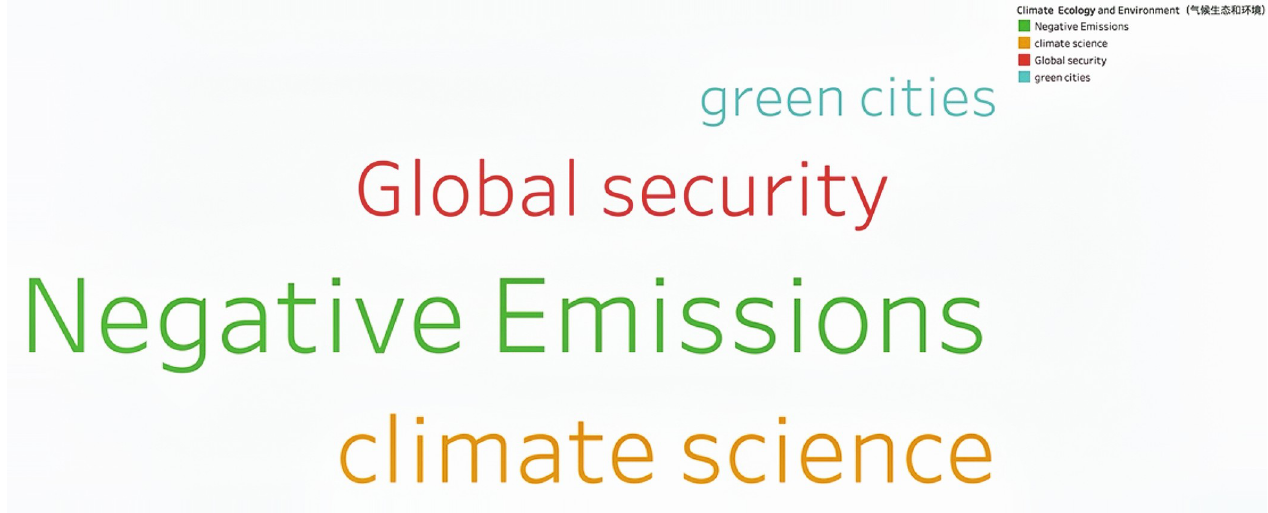
Fig 7. Word cloud diagram in the field of Climate Ecology and Environment.